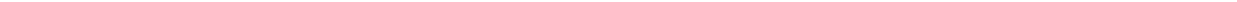
Fig. 4 MMP12 reduces IFN- γ signaling and responses in macrophages. a Mouse RAW264.7 cells were treated for 15 min or 24 h with PBS, 20 ng/mL mouse IFN- γ , 20 ng/mL mouse IFN- γ pre-incubated with 2 ng/mL mouse MMP12 (37 °C, 18 h), 2 ng/mL mouse MMP12 alone, or 30 ng/mL mouse IL-4 ( n = 4, N = 2). After 10% SDS-PAGE, cell lysates were western blotted for pSTAT1-Y701 and STAT1 proteins (Supplementary Fig. 7b). b Western blot